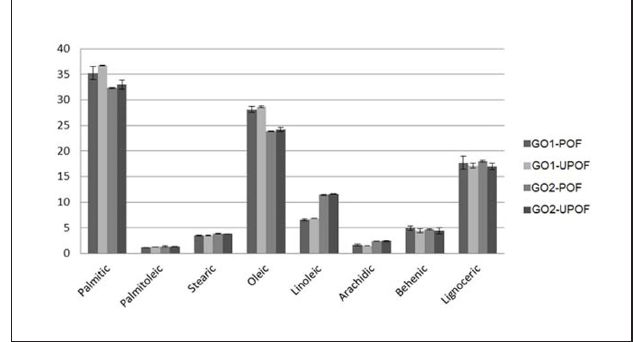
Fig. 2: The fatty acids of peeled (POF) and unpeeled (UPOF) oleaster flours from two genotypes (GO1 and GO2). Data show mean values of three replicates +/- standard